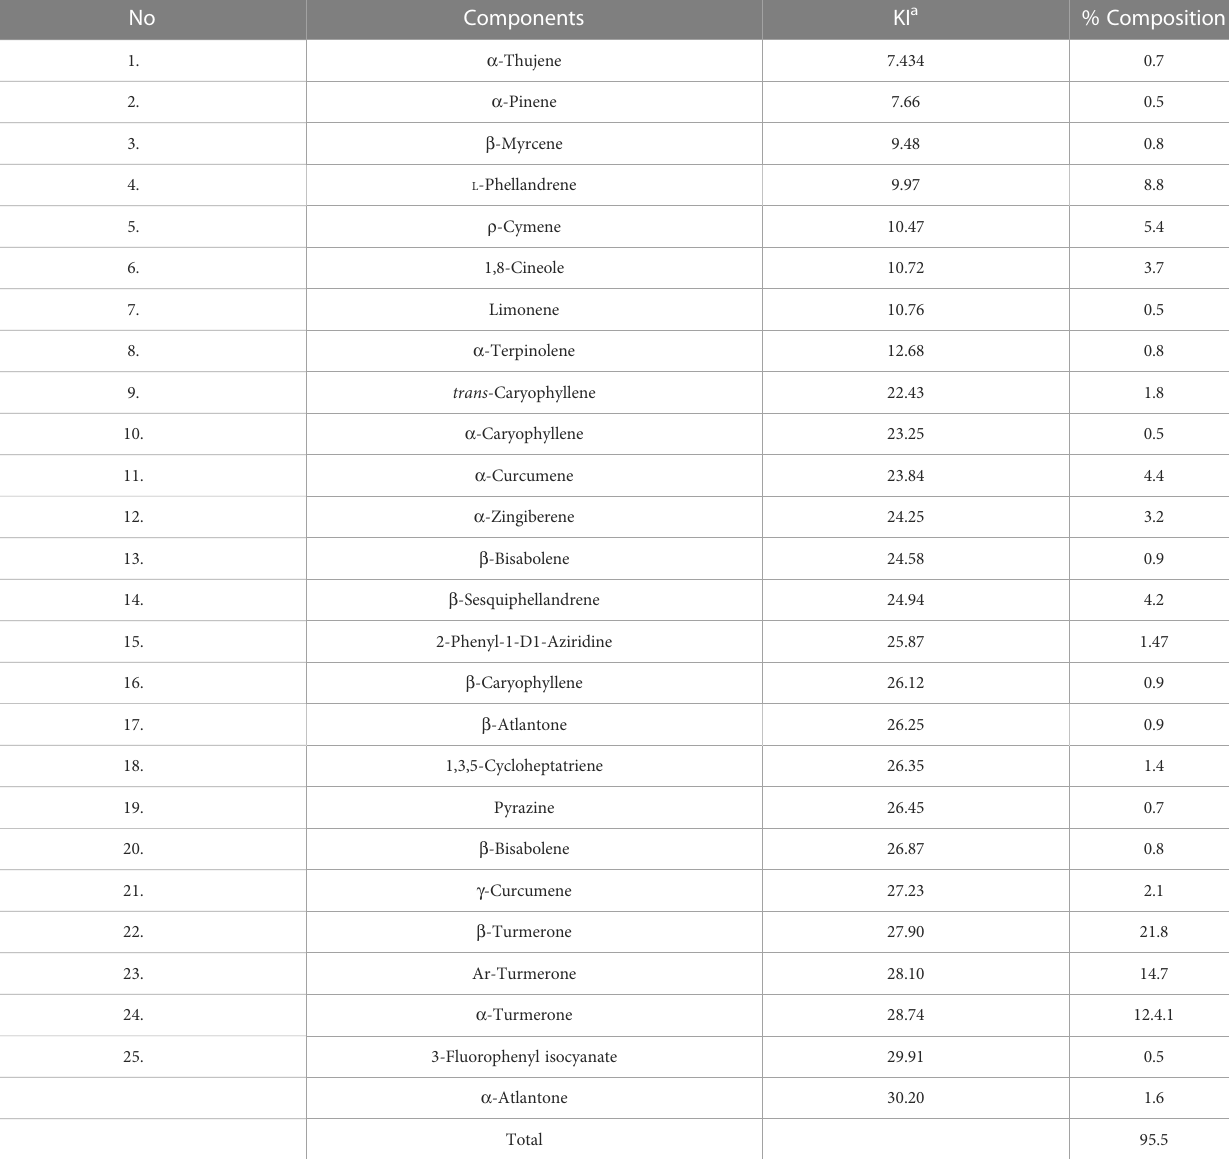
TABLE 2 GC/MS analysis of chemical compositions of Curcuma longa essential oil. No Components KI a % Composition